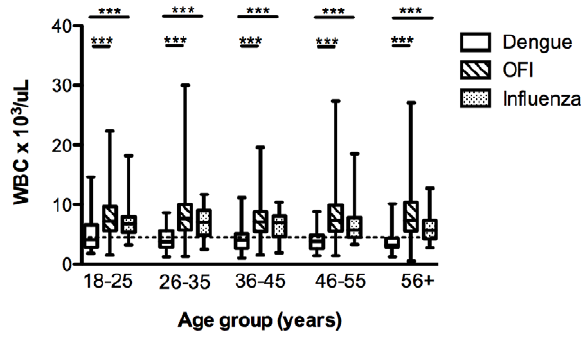
Figure 1. Age-group specific WBC in patients with dengue, OFI and influenza in the first 72 hours of illness. Box and whiskers (maximum and minimum) indicate the mean and spread of WBC in the different groups of patients. Dotted line indicates threshold for leukopenia (WBC , 4,500 cells/ m L). ***indicates p , 0.0001 as determined using the Mann Whitney U test.